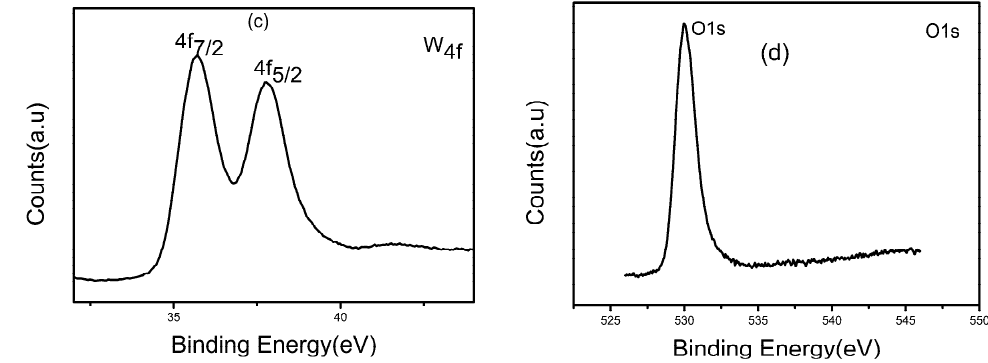
Figure 3. X-ray photoelectron spectroscopy (XPS) spectra of the hierarchical Bi 2 WO 6 hollow microspheres: ( a ) the typical survey; the high-resolution spectra of ( b ) Bi 4f , ( c ) W 4f , and ( d ) O 1s .